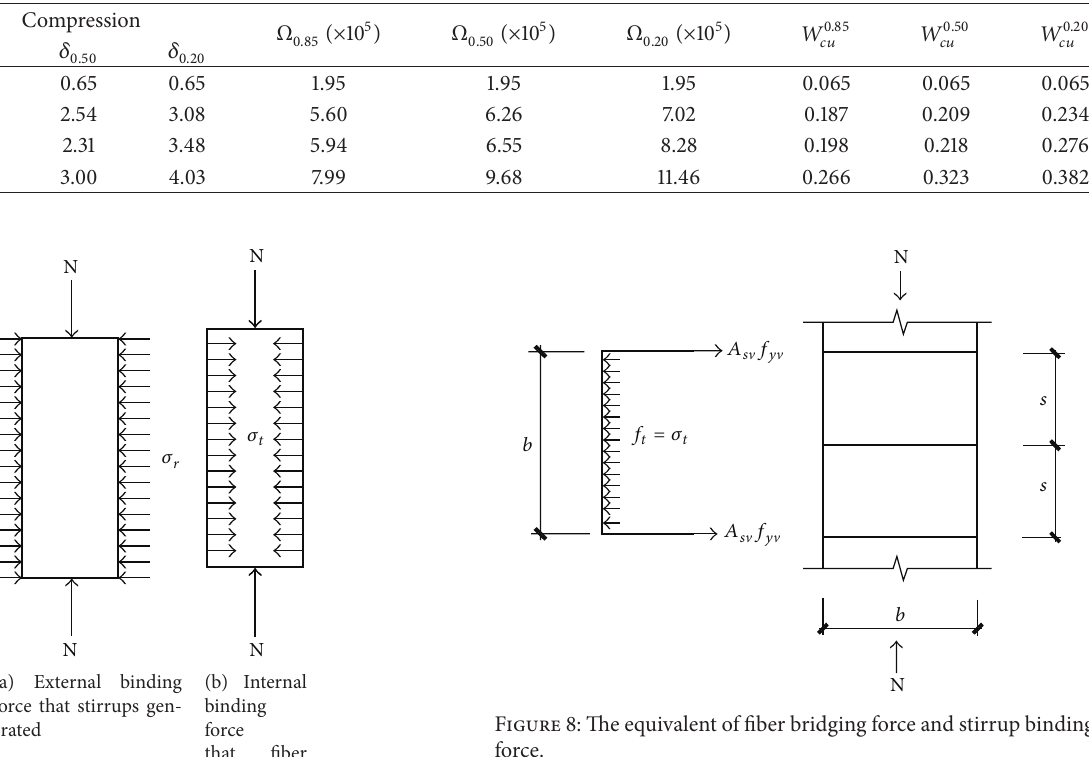
Table 4: The calculation results of equivalent compressive toughness.